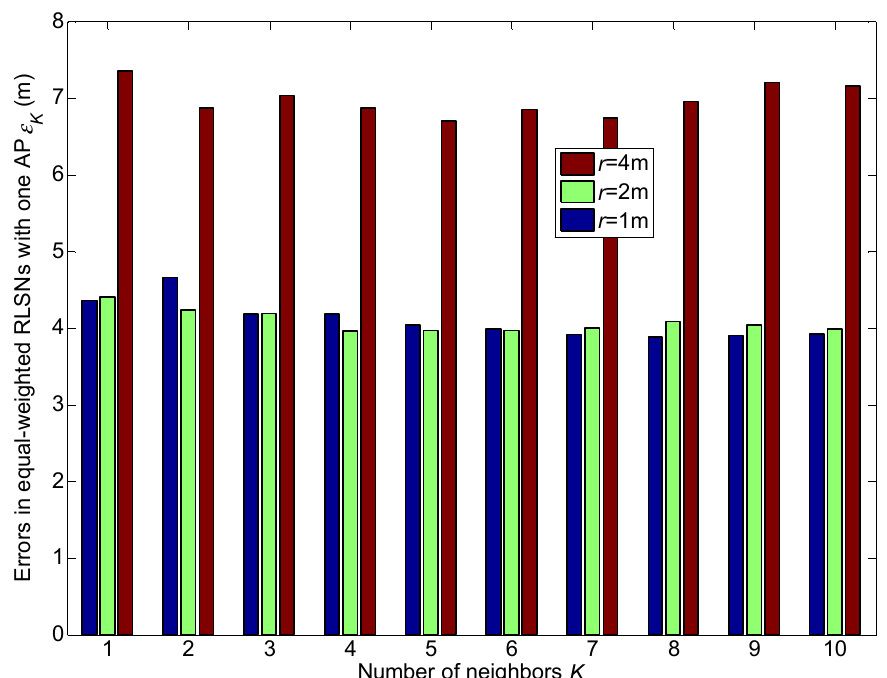
Figure 16. Localization errors in equal-weighted RLSNs with one AP (AP1).